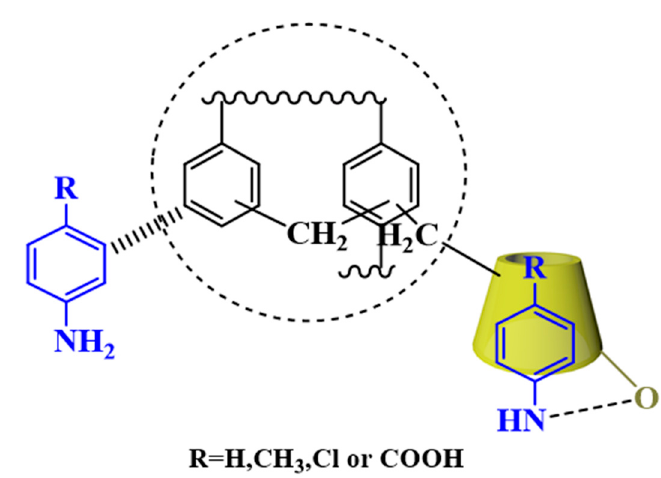
Figure 12. Schematic mechanism of the adsorption of anilines with the CDM-HCP.